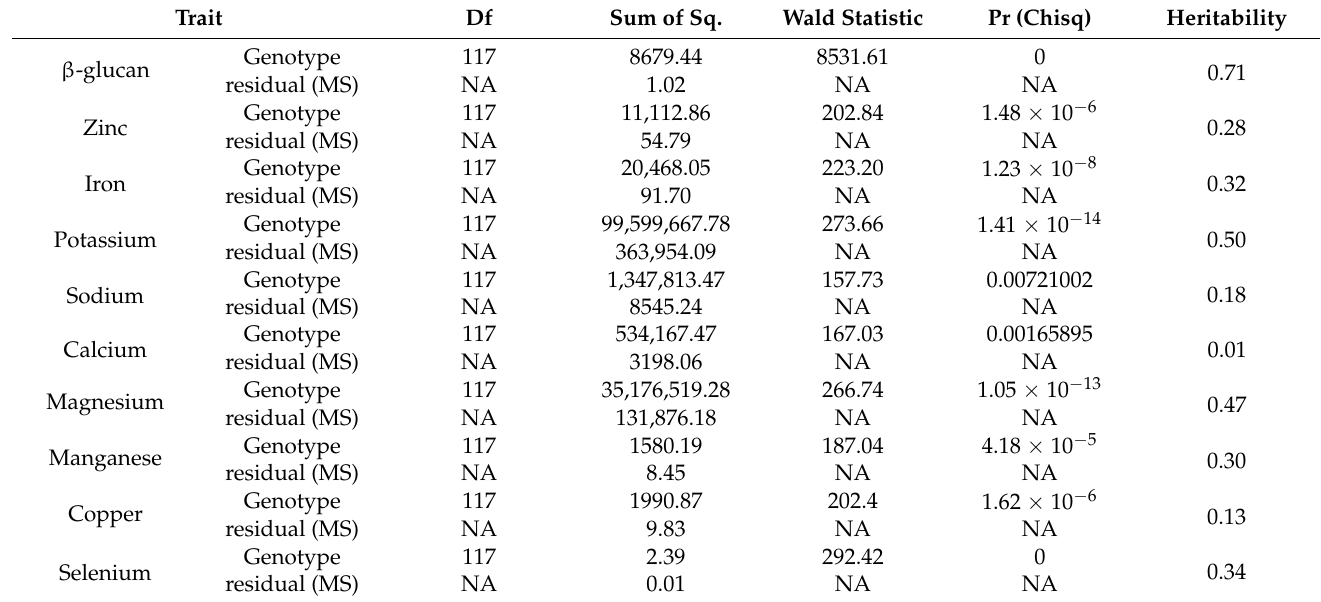
Table 3 summarized the mean, range, and standard deviation of dietary fiber and mi- croelement contents in flour. For β -glucan, its content expressed as percentage varied from